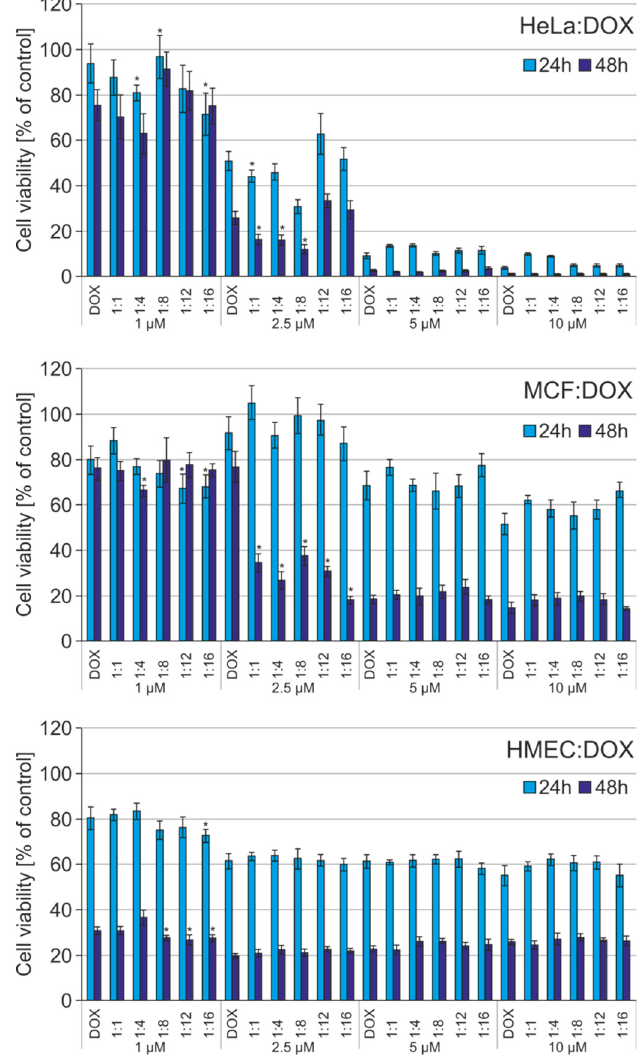
Figure 6. The influence of doxorubicin (DOX) and its polyhedral oligosilsesquioxanes (POSS) complexes at different molar ratios on cell viability of human cervical cancer endothelial (HeLa), human breast adenocarcinoma (MCF-7) and non-cancerous microvascular endothelial (HMEC-1) cells. POSS systems are found to be non-toxic [7]. Data are presented as a percentage of control (untreated cells) standard deviation (SD); * p < 0.05 (statistical significance between DOX and POSS:DOX complexes).